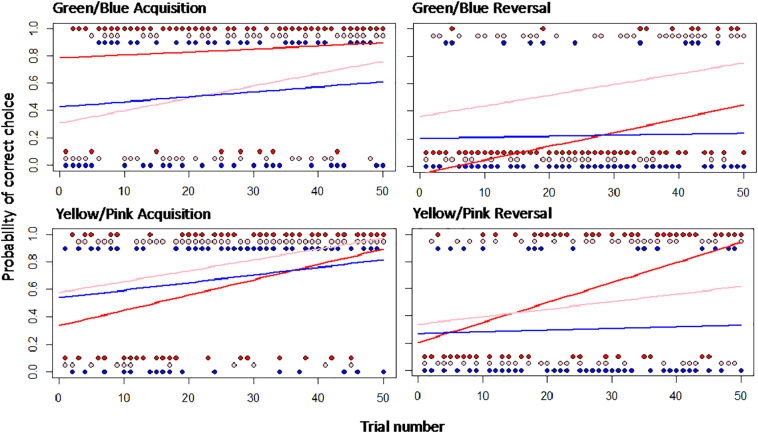
Individual performances across trials for each binary discrimination task. Performances are generated from learning curves that were derived from the probability of an individual making a correct or incorrect choice per trial. Individuals depicted are those with the highest (red line: bird 279), median (pink line: bird 384), and lowest (blue line: bird 441) single factor scores generated from PAF of their aggregate performances. (For interpretation of the references to colour in this figure legend, the reader is referred to the web version of this article.)